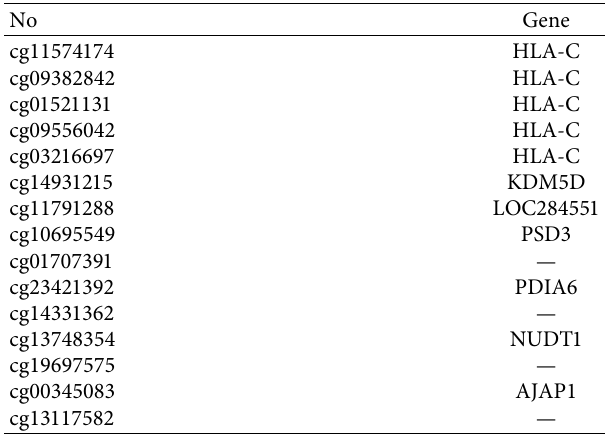
Figure 1: Diferentially methylated 5 ′ –C–phosphate–G–3 ′ (using 450K arrays) of the eutopic endometrium of healthy women and the eutopic and ectopic endometrium of patients with endometriosis; Eu-H is the eutopic endometrium of healthy women; Eu-P is the eutopic endometrium of patients with endometriosis; and Ec-P is the ectopic endometrium of patients with endometriosis ( ∗ P < 0 . 05). Table 2: Fifteen aberrantly methylated CpG sites and the mapped